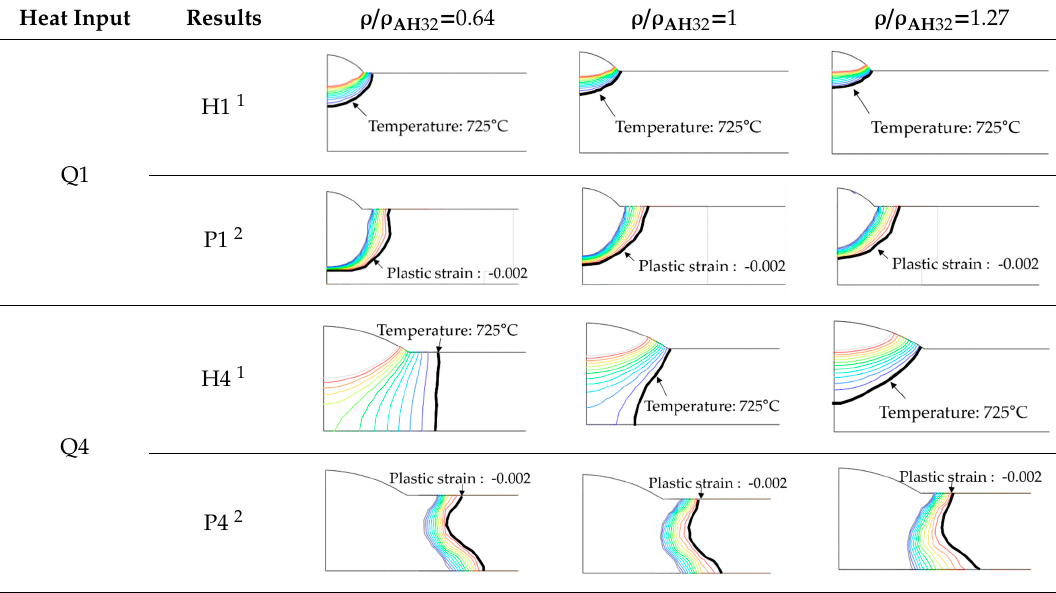
Table 7. Angular distortions calculated from heat transfer and thermal elastoplastic analyses compared according to density ratio.